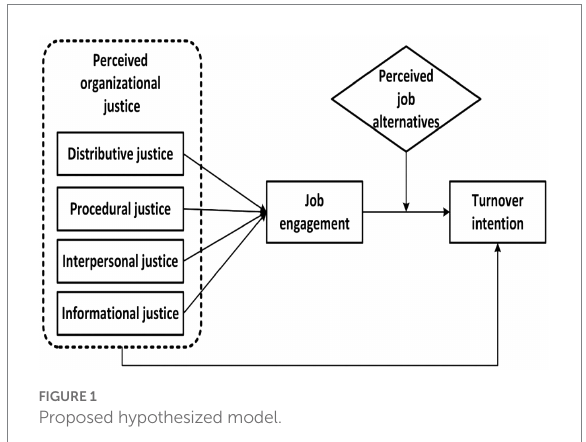
FIGURE 1 Proposed hypothesized